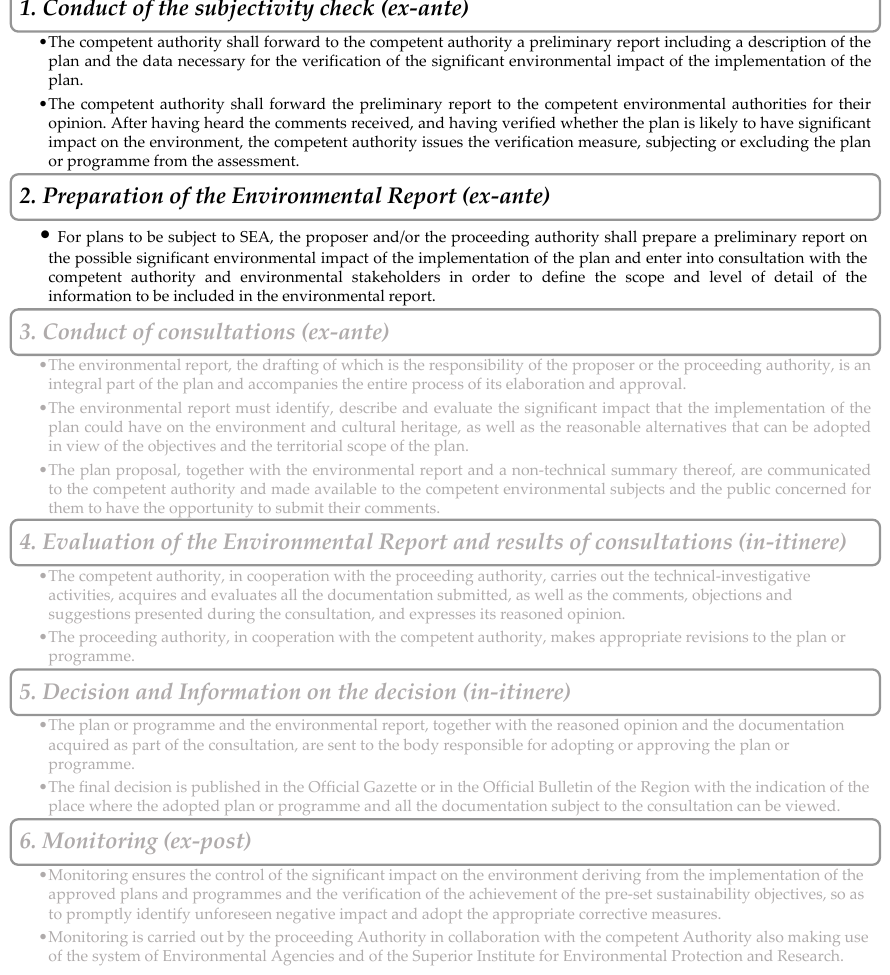
Figure 1. Phases ongoing of the SEA process inherent to the PRG Revision of the City of Turin .